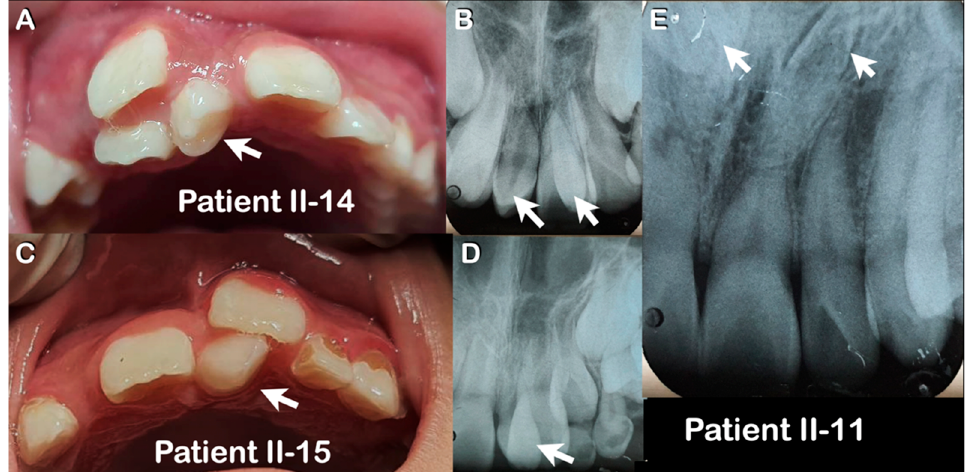
Figure 2. Clinical and radiographic pictures of mesiodens (arrows) in ( A ) Patient II-14. ( B ) Periapical radiograph in ( A ) shows double mesiodentes (arrows). ( C ) Patient II-15. ( D ) Periapical radiograph in ( C ) shows mesiodens. ( E ) Periapical radiograph of patient II-11. Note double inverted mesioden- tes (arrows).